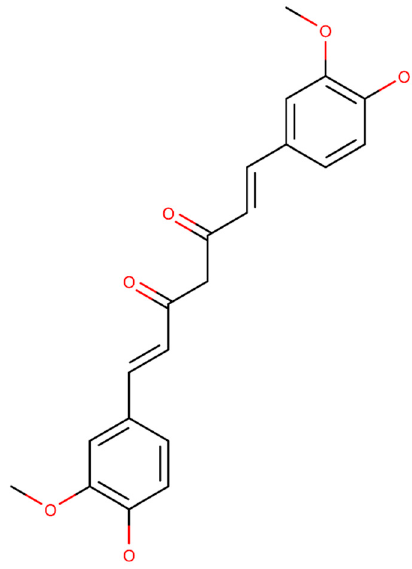
Figure 10. Chemical structure of curcumin.